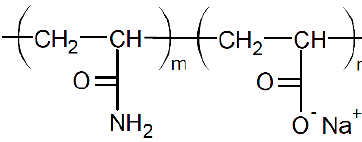
Figure 1. Structure of the acrylamide/acrylate copolymers studied.